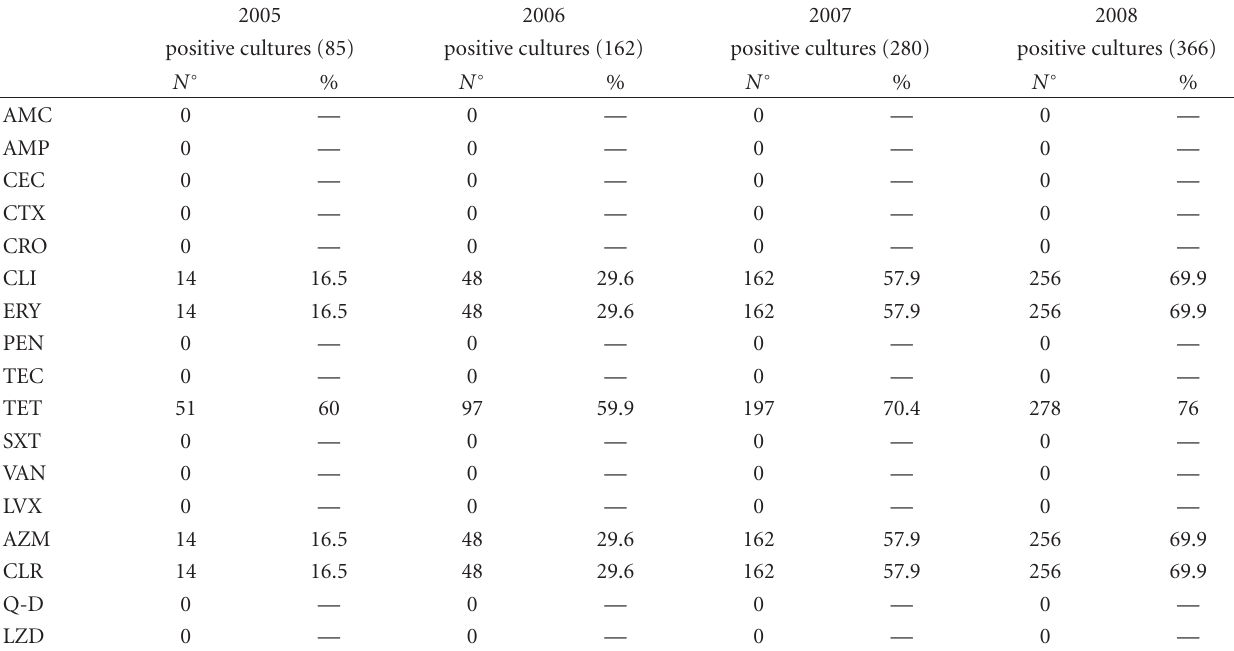
Table 1: Distribution of swab type, positive cultures, and number of infected patients.